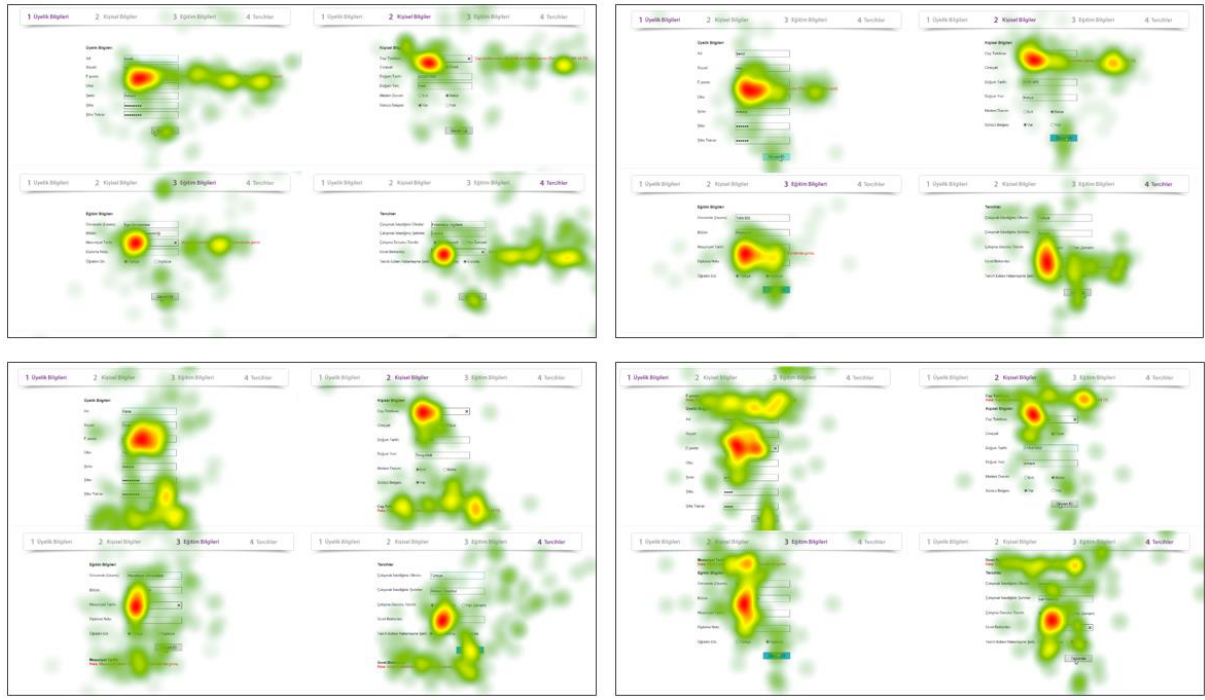
Figure 3. Heat maps of the participants’ saccades to error messages by each